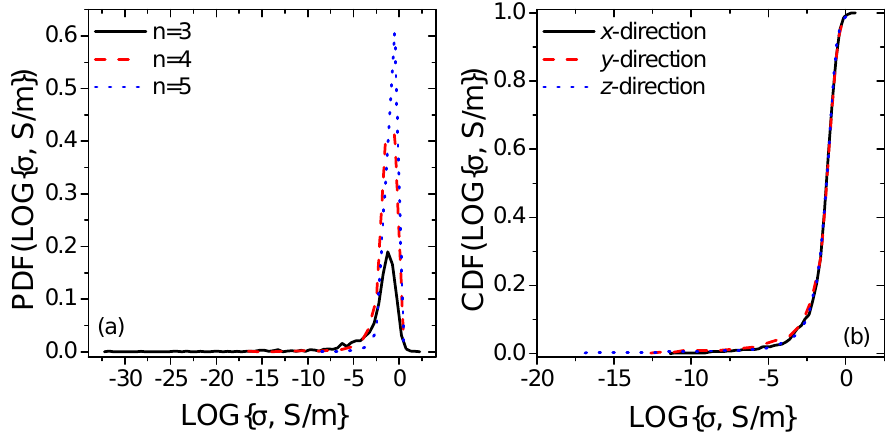
Figure 5. ( a ) Empirical PDF of the conductivity of the isotropic composite with 5 vol. % of CNTs with different cell size n . ( b ) Empirical CDF of the conductivity in different directions for the isotropic composite with 5 vol. % of CNTs with n = 4. 1500 realisations were collected.